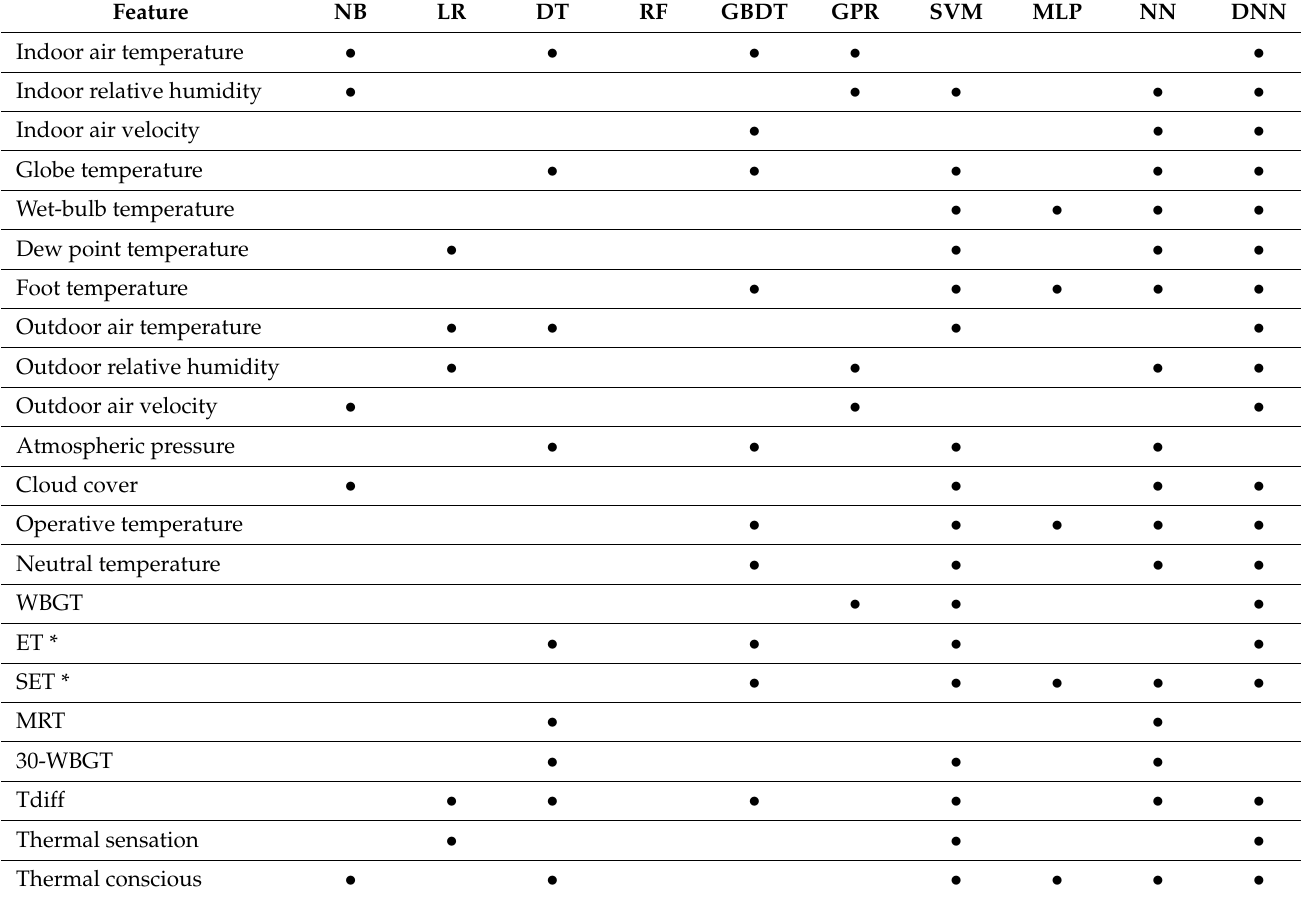
Table 9. Features selected for backward